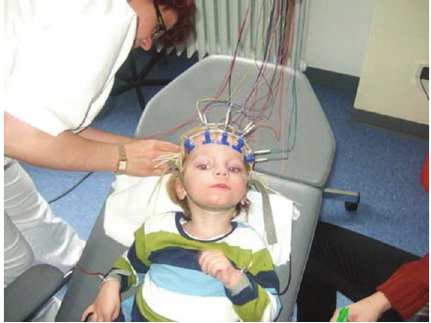
Figure 8: EEG recording (L. B.) before transplantation. EEG recording. The patient (L. B.) is in a persistent vegetative state 9 weeks after the insult before transplantation of cord blood cells. Note, the dilated, unresponsive pupils in spite of bright light from the ceiling (see video S3 in Supplementary Material